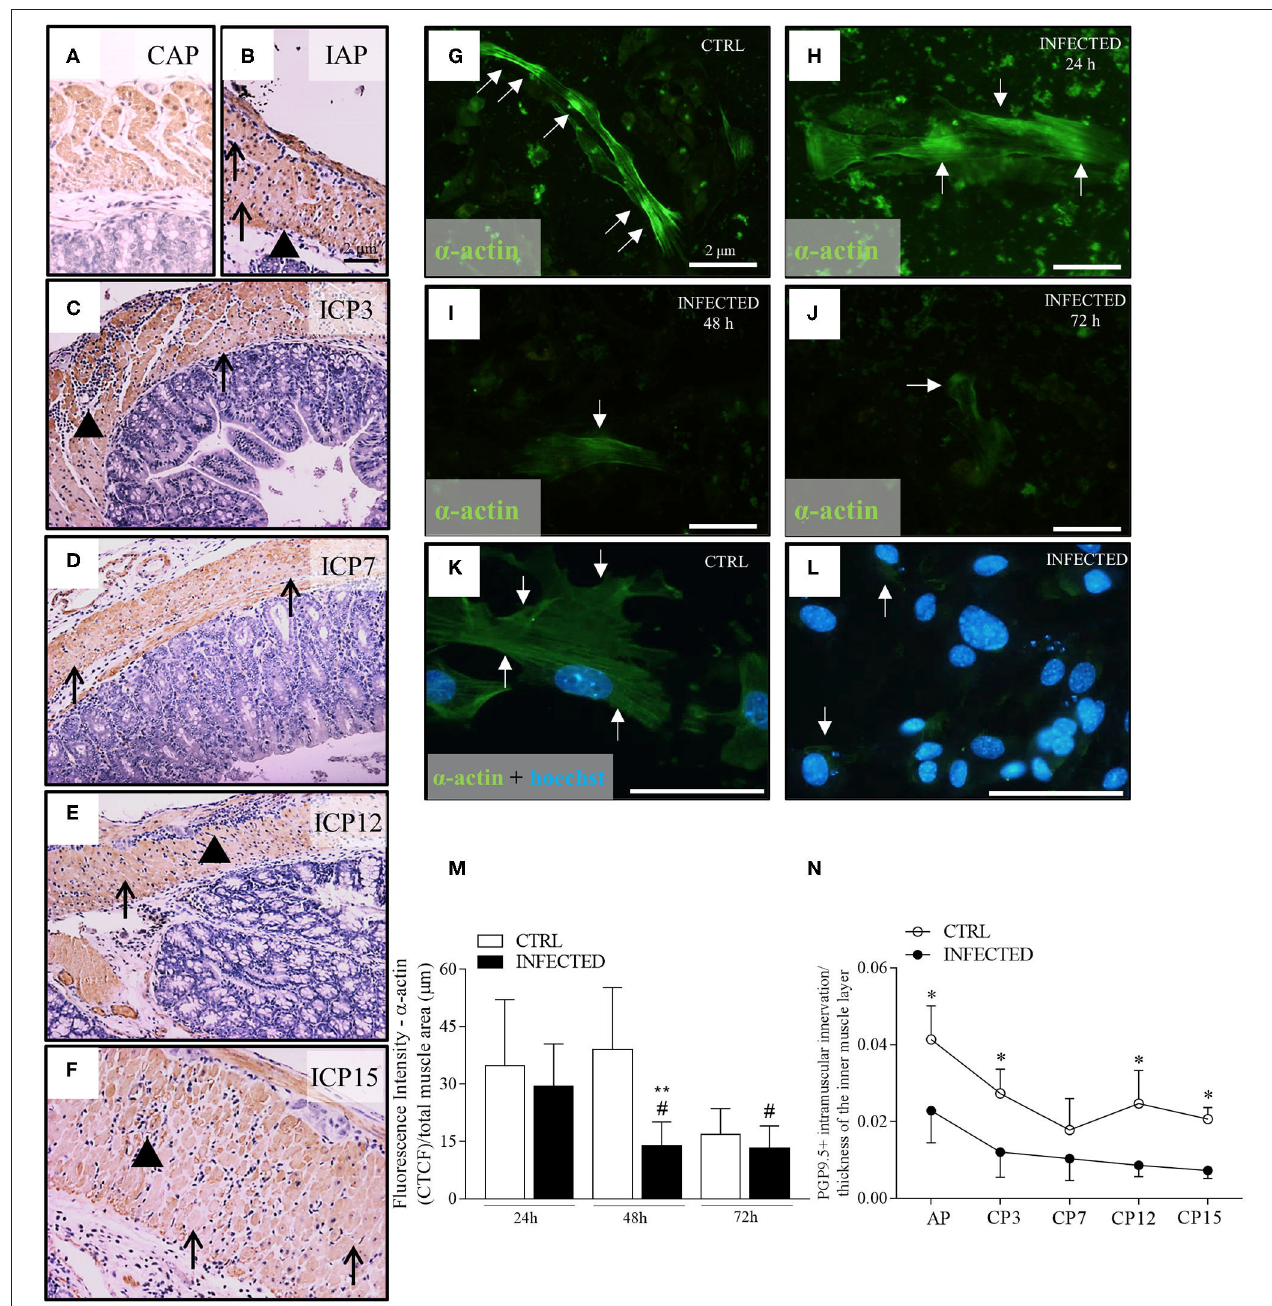
FIGURE 3 | Deranged smooth muscle α -actin immuno-expression in vivo and in vitro . (A) Colon control samples from Swiss mice were immunostained with anti- α -actin (B–F) Colon samples obtained from Swiss mice infected with 50,000 T. cruzi Y strain trypomastigotes were immunostained with anti- α -actin. Colon samples were obtained from animals in the acute phase (IAP) and chronic phase ICP (3, 7, 12, and 15 months post-infection-m.p.i.). Scale bar: 2 µ m. 10X objective. (G–L) Anti- α -actin immunofluorescence in control (CTRL) and infected primary enteric neuron cultures at 24, 48, and 72 h post-infection (h.p.i.). (G–J) Scale Bar: 2 µ m. 20X objective; (K,L) Scale Bar: 2 µ m. 40X objective. (M) Quantitative analysis of fluorescence intensity throughout infection (fluorescence Intensity of α -actin/total muscle area). ( n = 3 mice). Data are representative of two independent experiments. (N) PGP 9.5 + intramuscular innervation/thickness of the inner muscle layer ( n = 4). Data are representative of two independent experiments, in triplicate coverslips. Statistical analysis: ANOVA two-way with Student-Newman-Keuls tests. *Difference in relation to the control group, P ≤ 0.05. **Difference in relation to the respective control group, P < 0.01. # Difference in time in relation to the 24h.p.i., P < 0.05. Data are shown as mean and standard deviation (SD). Arrowheads indicate the inflammatory infiltrate. Black arrows indicate a decrease and/or absence of immunostaining for anti- α -actin in the internal muscle. White arrows indicate fluorescence for anti- α -actin. (K,L) Nuclear staining with Hoechst 33342.